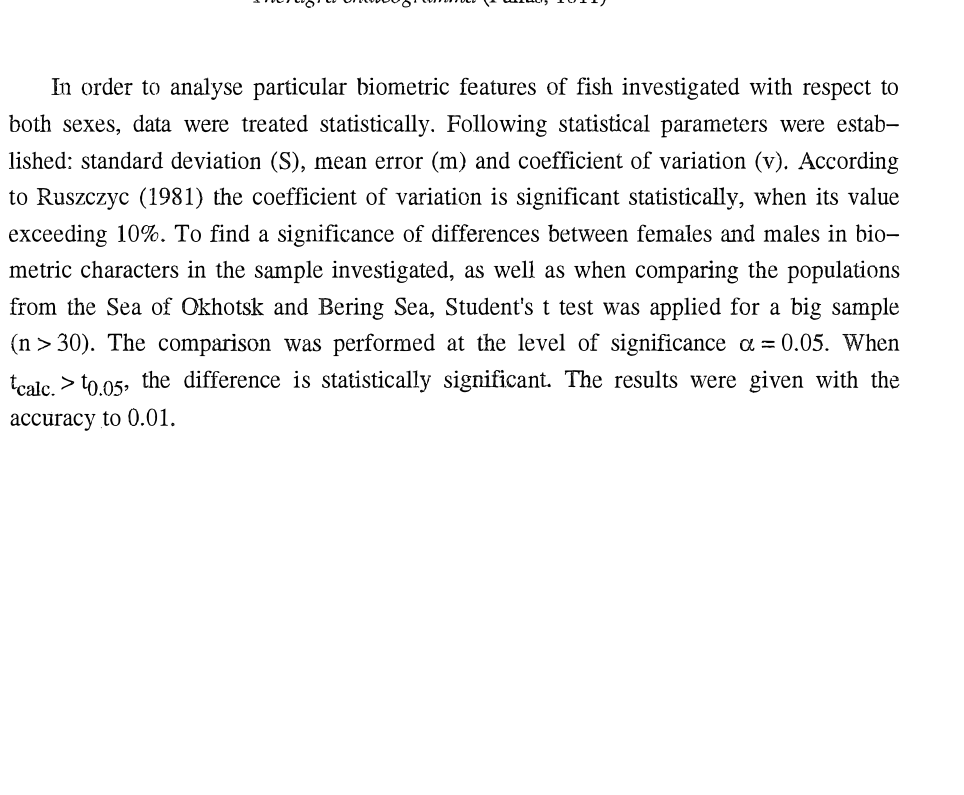
Fig. 3. Diagram of measurements made on walleye pollock Theragra chalcogramma (Pallas, 1811)